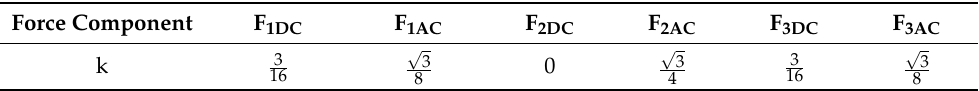
Table 1. Values of factor k for set of three conductors supplied from three-phase network; subscripts are as in Figure